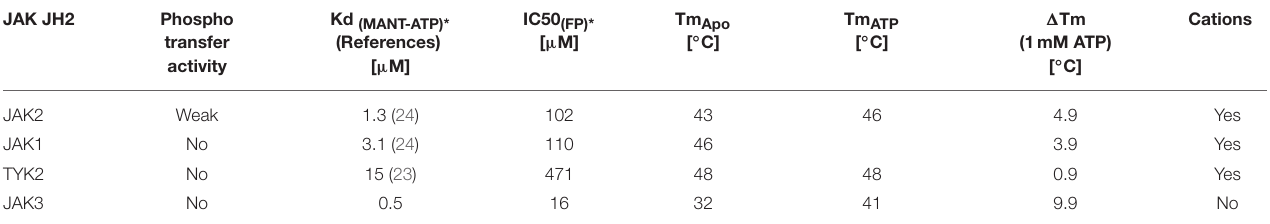
TABLE 2 | Comparison of JAK JH2s. JAK